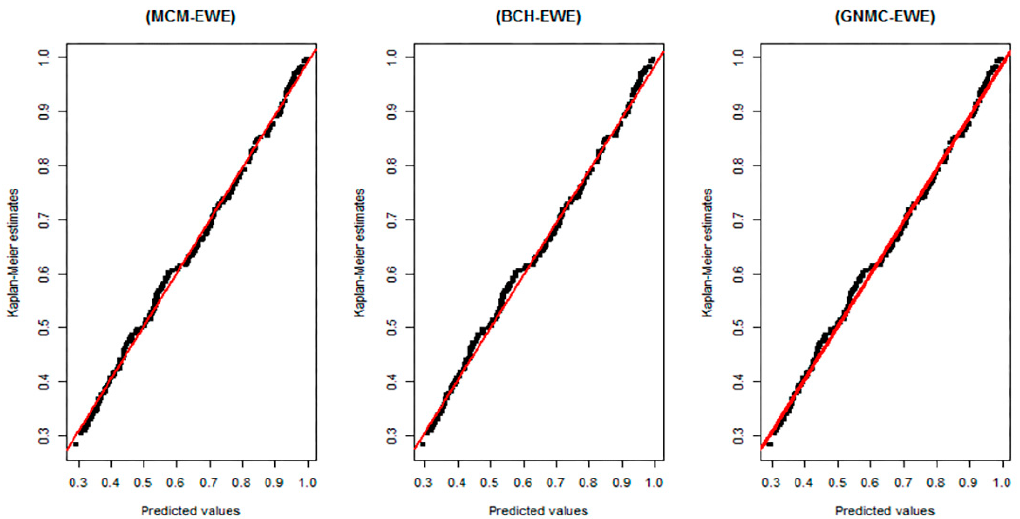
Figure 3. Plots of the Kaplan–Meier estimates for the survival functions versus the respective estimated survival values provided by MCM, BCH and GNMCM based on the EWE distribution. An ideal consent between the predicted survival values and Kaplan–Meier estimates is represented by the diagonal straight lines.